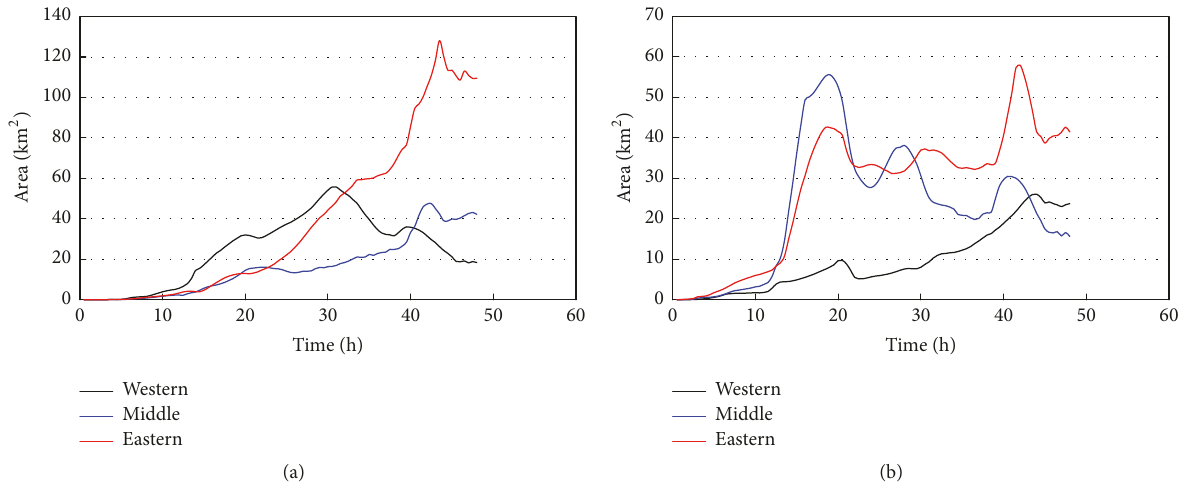
Figure 21: Area of instantaneous (a) and continuous (b) oil spills versus time in different spill locations (black line for the western spill location, blue line for the middle spill location, and red line for the eastern spill location) under the influence of southwest winds.